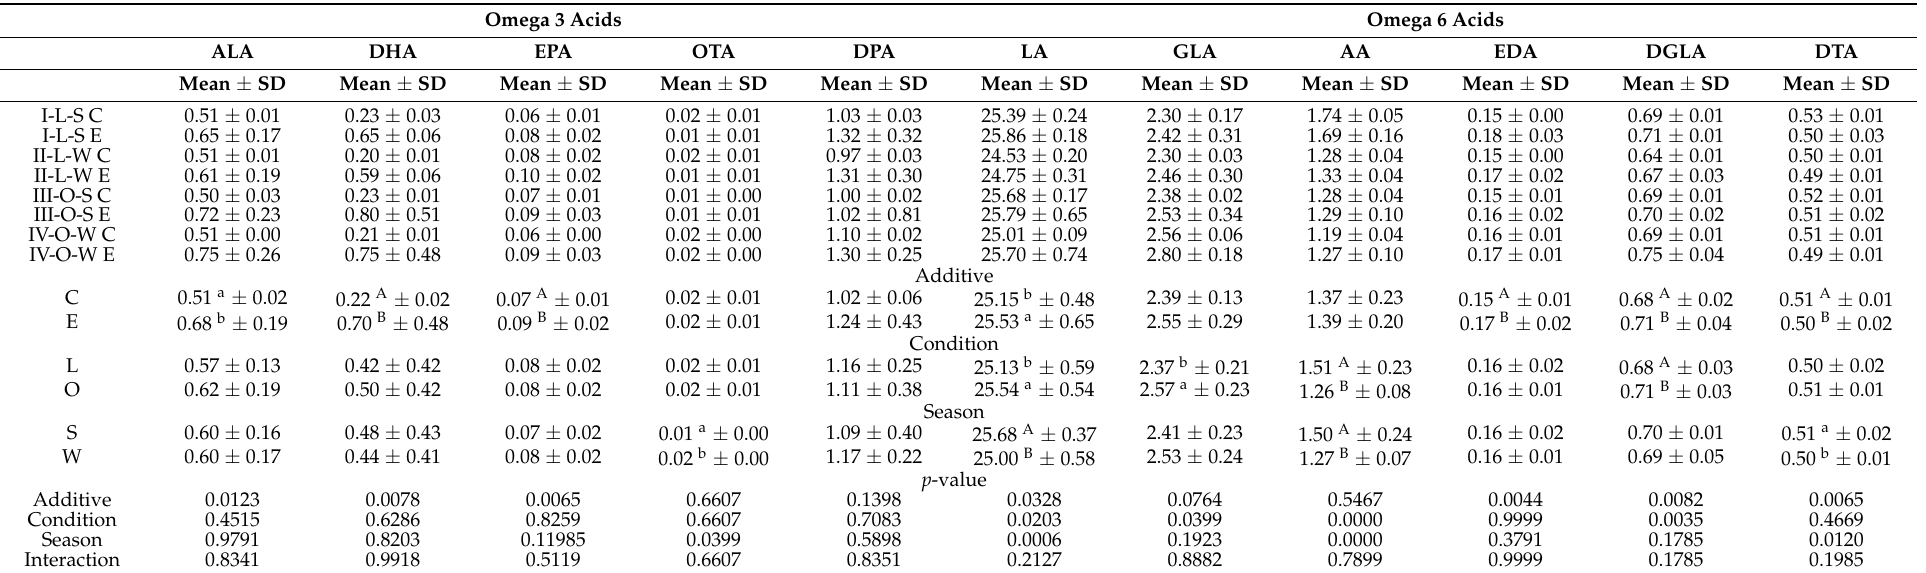
Table 9. Content of omega 3 and omega 6 fatty acids in rabbit blood